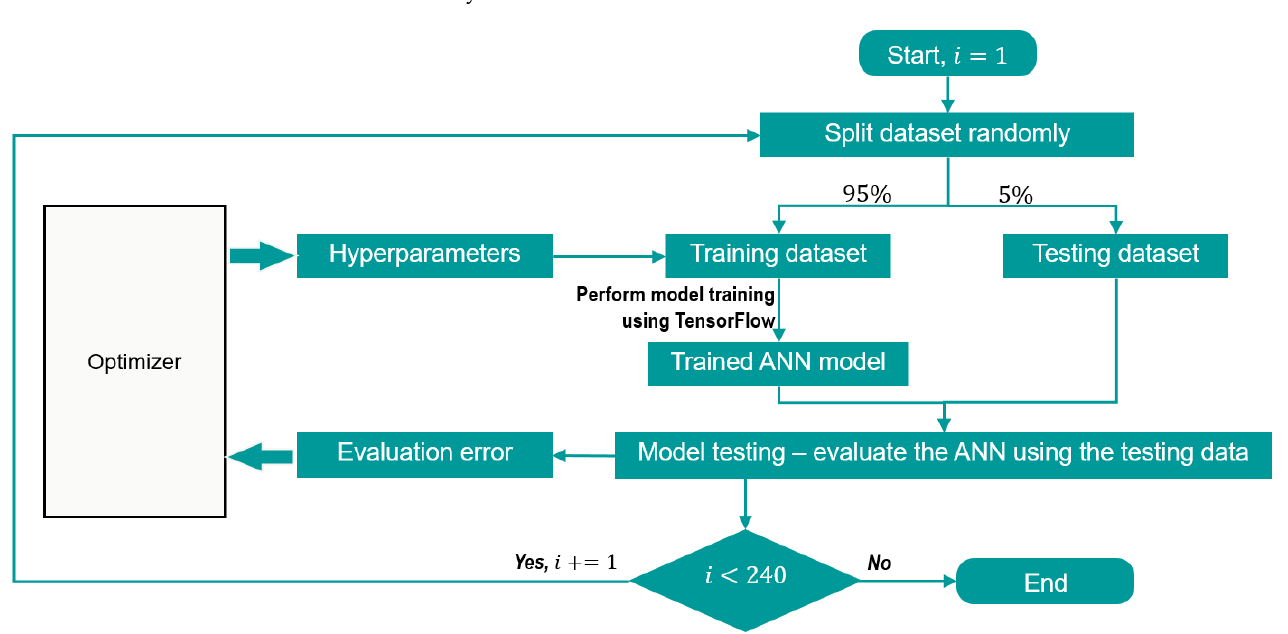
Figure 2. ANN model optimization diagram.